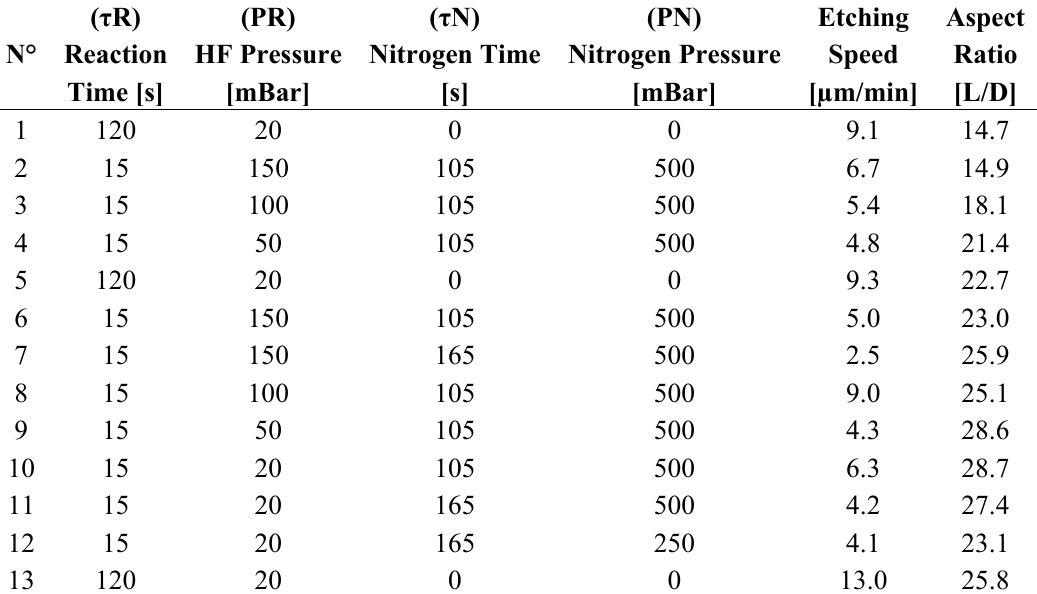
Table 1. Results obtained.